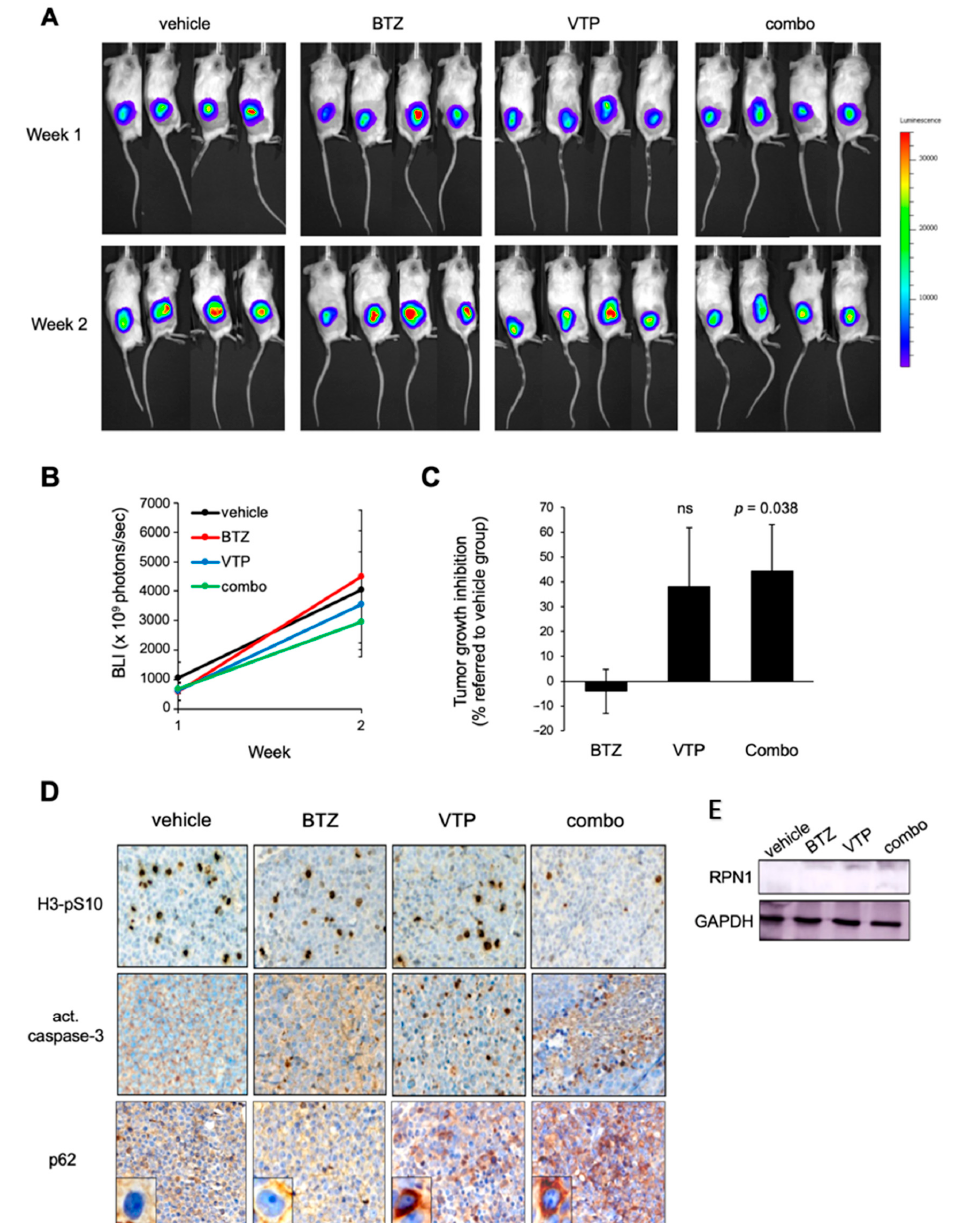
Figure 6. p62 inhibition reduces tumour growth in a BZT-resistant MCL xenograft model. ( A ) NSG mice were subcutaneously injected with REC1-GFP+Luc+ cells and tumor-bearing mice were ran- domly assigned to one of the following treatment arms ( n = 4 mice per group): BTZ, 0.5 mg/kg twice weekly (i.p.); VTP, 20 mg/kg twice weekly (i.p.), both agents or equal volume of vehicle, for two weeks. Tumor burden was evaluated at week 1 and week 2 by analysis of the bioluminescence signal. ( B ) Luciferase activity was quantified using Living Image software. ( C ) Tumor volume was evaluated ex vivo using calipers, upon euthanasia of the animals. The inhibition of tumor growth relative to the control group is reported in the histograms. ( D ) Immunohistochemical labelling of phosphorylated histone H3 (H3-pS10) as a marker of proliferating cells and activated (act.) caspase-3 as a marker of apoptosis, and p62 in consecutive tissue sections from four representative tumor specimens ( × 500, magnification) after 2 weeks of treatment. ( E ) RPN1 protein levels were evaluated by WB analysis in four representative tumor samples after the 2 weeks of treatment. ns, not